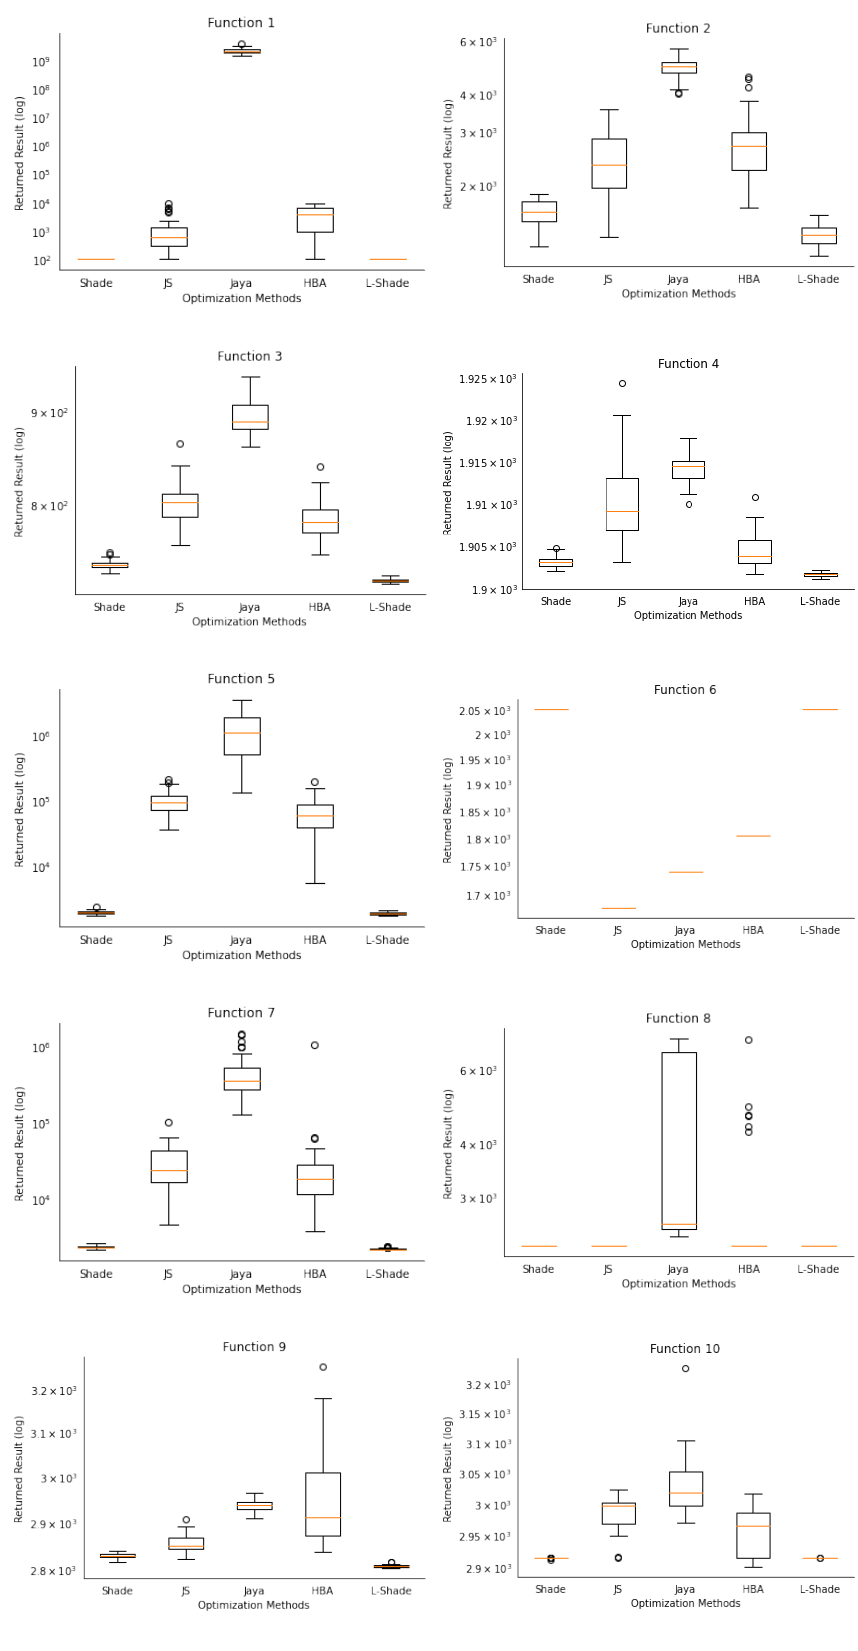
Figure 4. Box-and-Whiskers plots comparing the performance of the algorithms on the 10